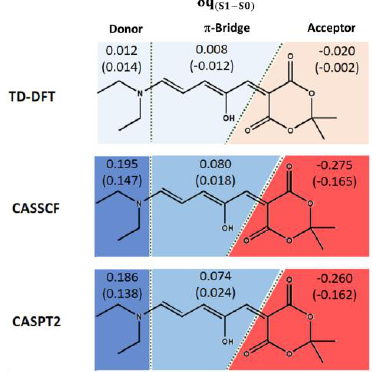
Figure 5. Mulliken charge analysis at TD-DFT (B3LYP and CAM-B3LYP), CASSCF, and CASPT2 levels For each group, the charge difference between ground and the lowest singlet excited state, δ q (S1–S0) , is given in vacuum, and in brackets when including methanol as solvent by the polarizable continuum model (PCM). The background color intensity is proportional to the charge value (blue: positive charge; red: negative